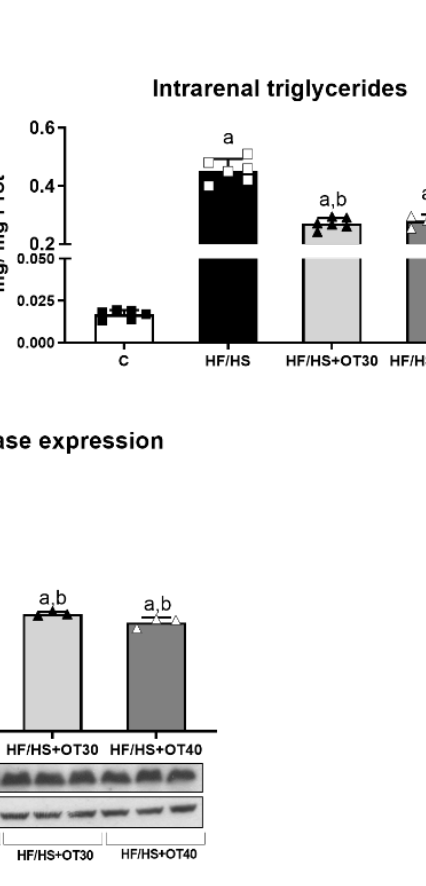
Figure 4. Assessment of the fructokinase (KHK) axis. ( A ) Activity and expression of KHK activity in the kidney and ( B ) intrarenal levels of uric acid and triglycerides and renal xanthine oxidase (XO) expression. For Western blotting, 3 randomly selected samples per group were analyzed. Results are presented as the mean ± SD and analyzed by one-way ANOVA. Post hoc analysis was performed using Bonferroni’s test. a: p < 0.05 vs. C; b: p < 0.05 vs. HF/HS; c: p < 0.05 vs. HF/HS +